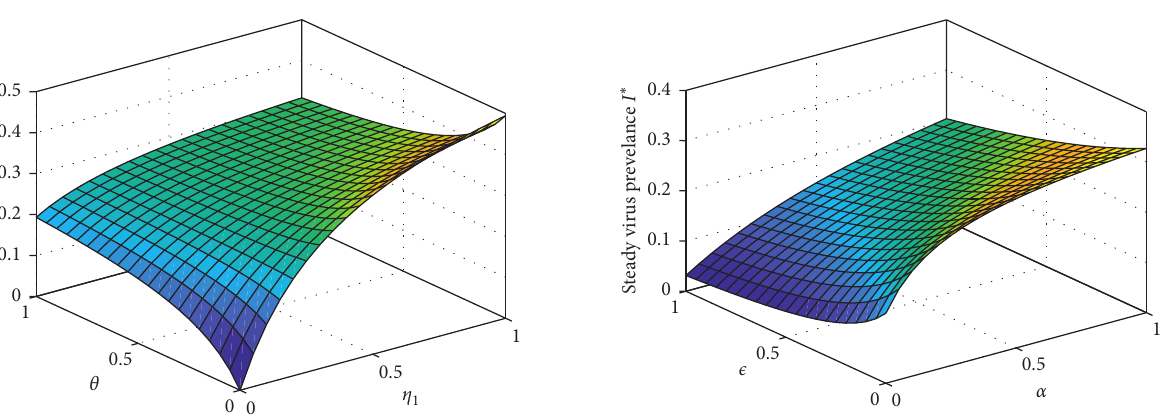
Figure 6: An illustration of the effect of θ and η